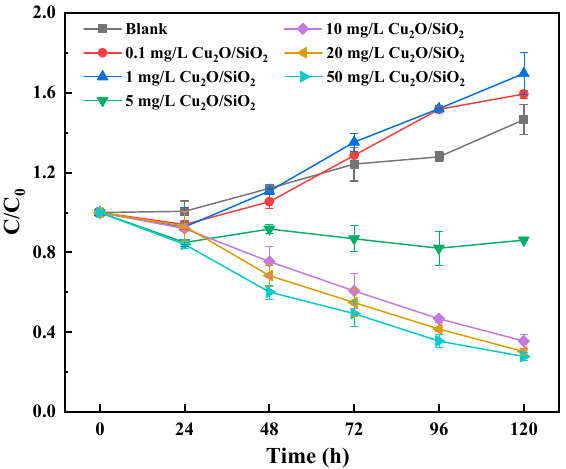
Figure 4. E ff ects of di ff erent concentrations of Cu 2 O / SiO 2 on the content of chlorophyll a in M. aeruginosa Figure 4. Effects of different concentrations of Cu 2 O/SiO 2 on the content of chlorophyll a in M. aeruginosa .